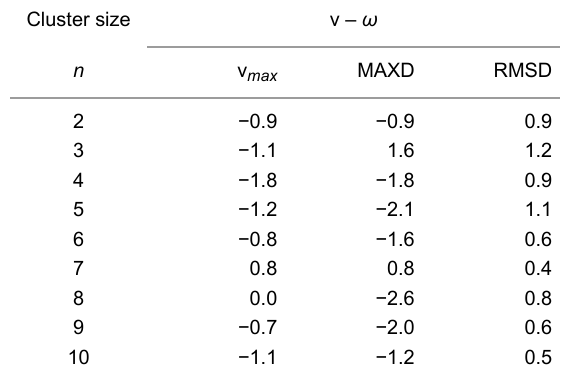
Table 5: Differences between anharmonic ( ν ) and harmonic ( ω ) frequencies for the global minima of bare planar clusters Au 2 to Au 10 obtained using PBE/VDB, in cm − 1 . The anharmonic results are obtained from fast-VSCF/VCI calculations for clusters with size and from standard VSCF/VCI calculations for the smaller clusters. For each cluster, we report the difference for the highest frequency mode ( ν max ) in the cluster, the maximum difference (MAXD), and the rms deviation for all normal modes (RMSD). Cluster size ν –